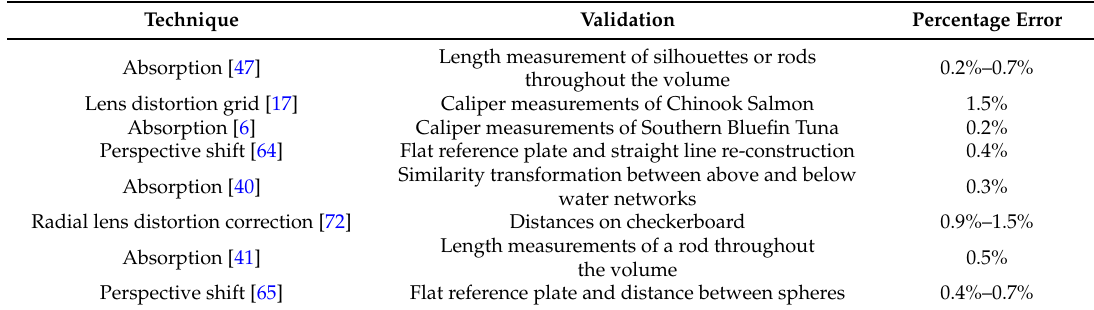
Table 3. A sample of some published results for the validation of underwater camera